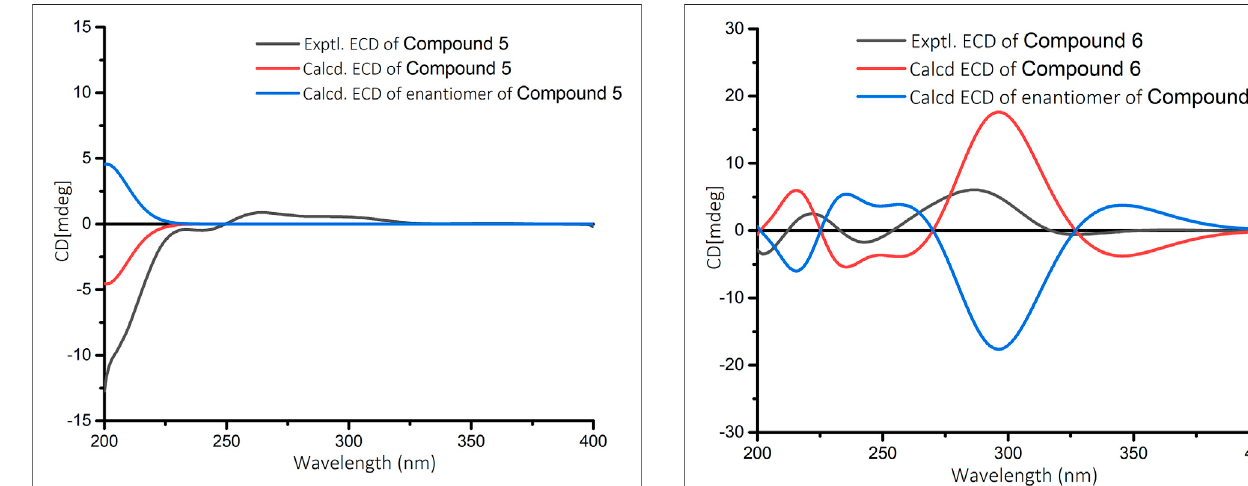
FIGURE 9 | Calculated and experimental ECD spectra for compound 6 in